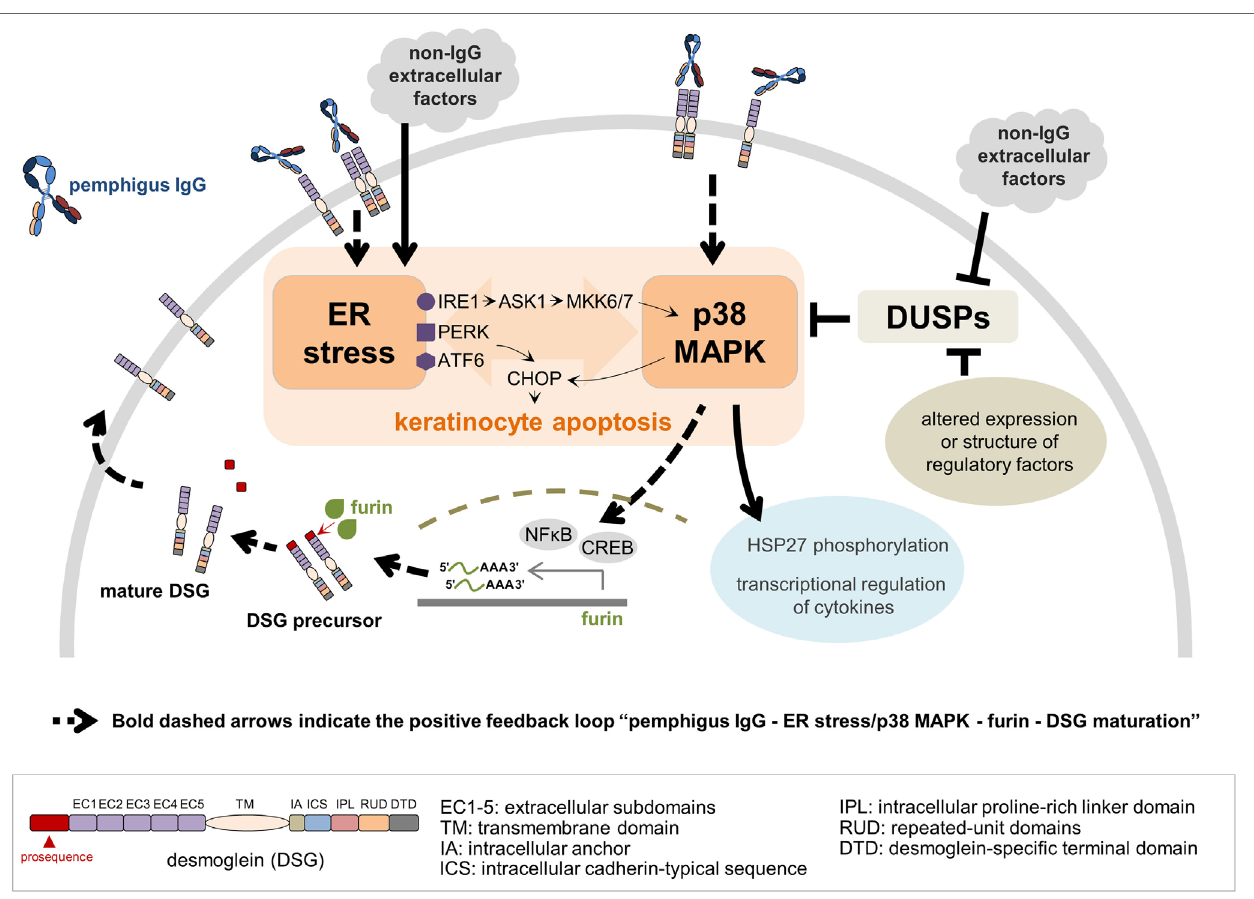
FiGUre 2 | A model for a crosstalk between endoplasmic reticulum (ER) stress and p38 mitogen-activated protein kinase (p38 MAPK) pathway in the context of pemphigus. Both pemphigus IgG and non-IgG extracellular factors lead to ER stress resulting in C/EBP-homologous protein (CHOP) induction via protein kinase R-like ER kinase (PERK) and activating transcription factor 6 (ATF6). ER stress activates p38 MAPK through the inositol-requiring kinase 1 (IRE1)-apoptosis signal-regulating kinase 1 (ASK1)-MKK6/7 signaling pathway, and CHOP is activated by p38 MAPK. Pemphigus IgG binding preferentially to mature desmoglein (DSG) 1 and/or 3 activates the p38 MAPK pathway, which in turn induces ER stress. Dual-specificity phosphatases (DUSPs), negative regulators of p38 MAPK activation, can be targeted by either non-IgG extracellular factors or intracellular regulatory factors, such as RNAs and proteins, with altered expression or structure. ER stress and p38 MAPK play a critical role in keratinocyte apoptosis, heat shock protein 27 (HSP27) phosphorylation and transcriptional regulation of cytokines. In addition, activation of nuclear factor kappa-light-chain-enhancer of activated B cells (NF κ B) and cAMP-responsive element binding protein (CREB) by p38 MAPK signaling pathway positively regulates FURIN transcription, which ultimately facilitates the DSG maturation process. As more mature DSG becomes available on the keratinocyte’s plasma membrane, the entire process restarts, characterizing the positive feedback